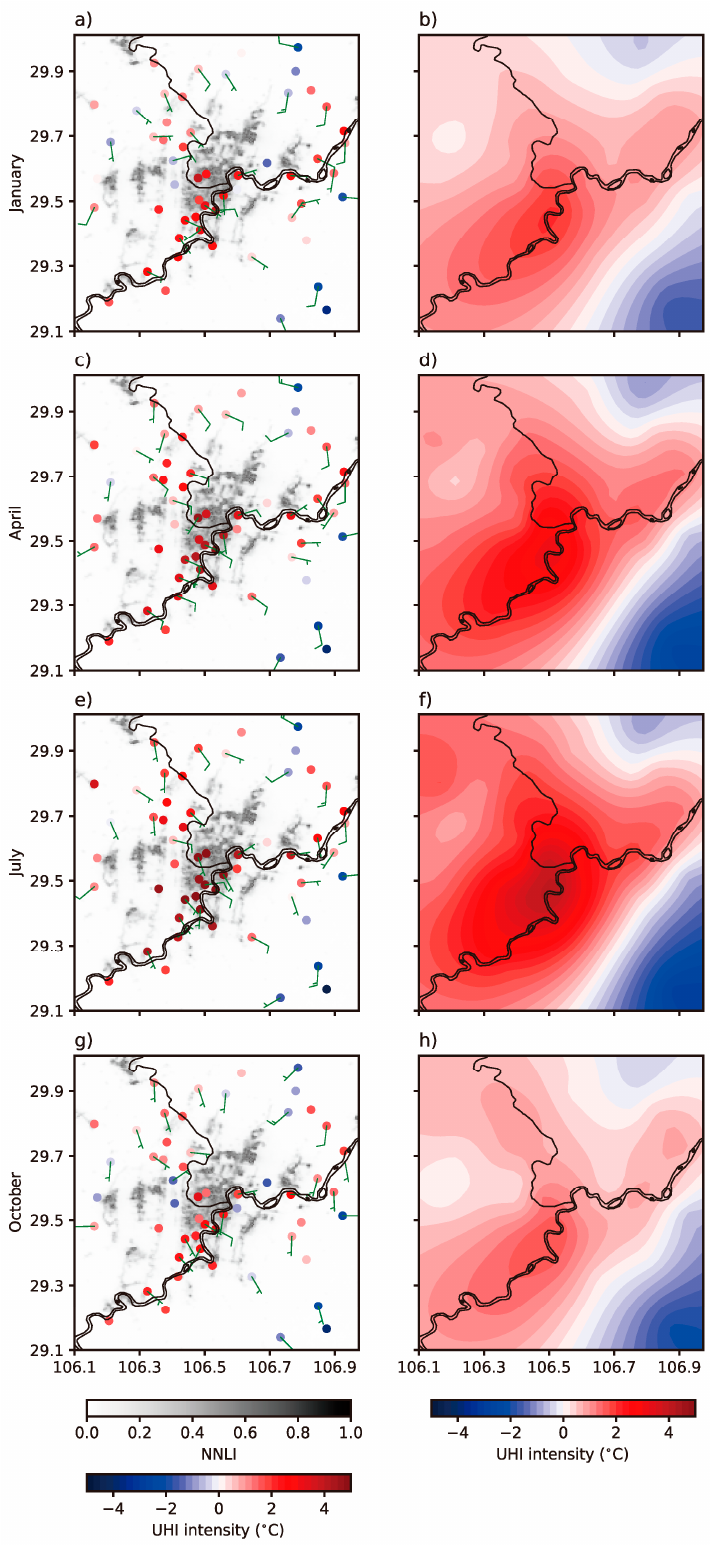
Figure 10. Spatial distribution of mean UHI intensity (°C) and winds (m/s) at ( a – b ) January, ( c – d ) April, ( e – f ) July, and ( g – h ) October at 00 LST of the day. Left column: scatter plot of UHI intensity (dots) and winds (barbs). A half (full) barb is 0.5 (1.0) m/s, and only the winds ≥ 0.5 m/s are shown. Shades are NNLI. Right column: spatial pattern of UHI intensity using the kriging interpolation method.